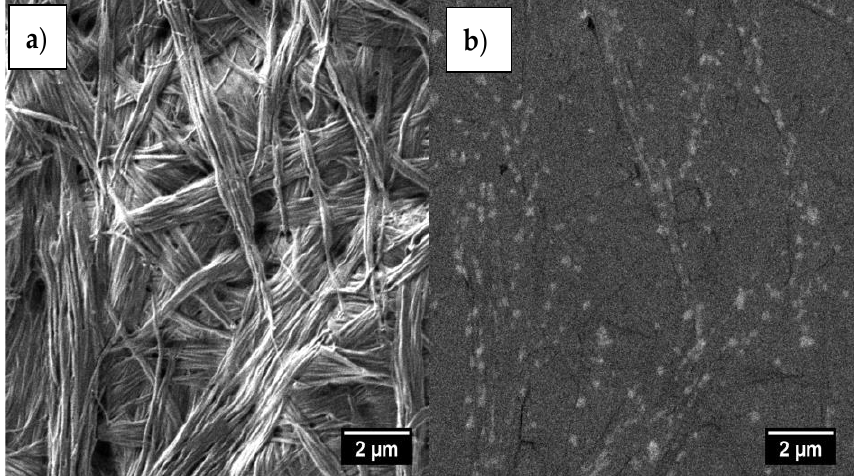
Figure 8. SEM micrographs of the benzene@4cb*HCl xerogel sample obtained for the same area by ( a ) SE2 and ( b ) BSE detectors. Scale bar is 2 μ m.